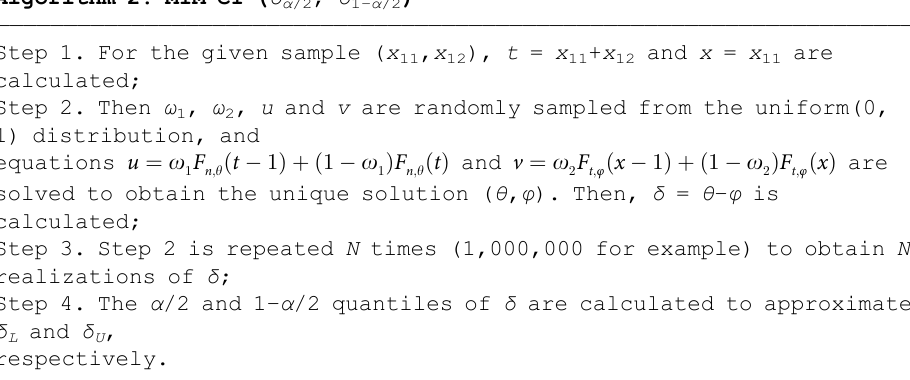
Algorithm 2: MIM CI ( δ α /2 , δ 1− α /2 )